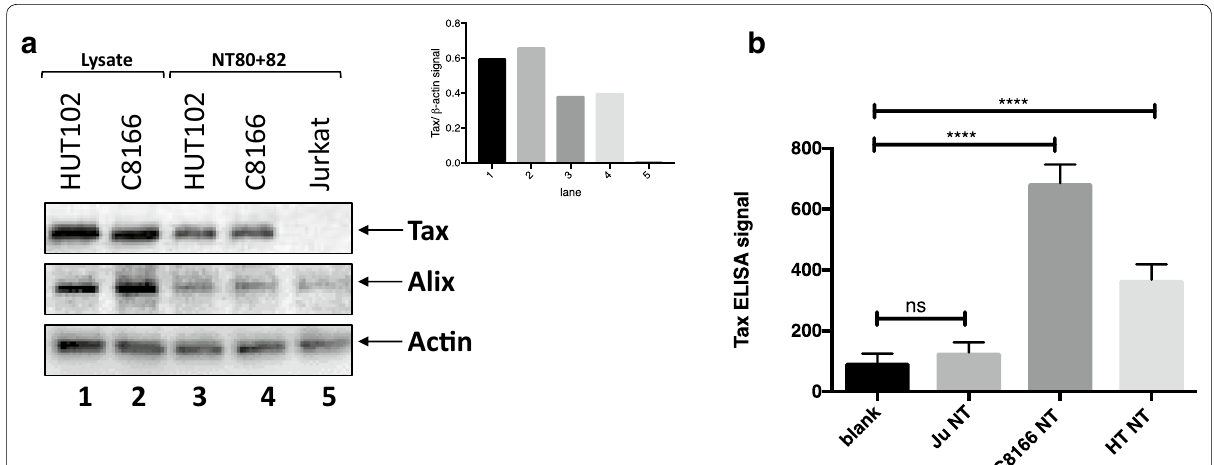
Fig. 2 HTLV‑1 infected cell lines have exosomes containing HTLV‑1 Tax protein. a Western blots for levels of HTLV‑1 Tax, Alix and β‑actin (Actin) proteins were performed from cell lysates and NT80 82 nanotrapped exosomes from HUT102 and C8166 (C81) cells. Jurkat cell supernatants were + also nanotrapped with NT80 82 particles and run alongside infected cell NT pulldowns. Tax levels detected were normalized to the β‑actin signal + for each sample and quantified in the upper right inset. b HTLV‑1 Tax was measured by electrochemical ELISA. Nanotrapped (NT80 from Jurkat (Ju), C8166 (C81), and HUT102 (HT) cells were freeze‑thawed and then measured for HTLV‑1 Tax reactivity. Statistical significance was determined by unpaired t ‑test. **** p ‑value < 0.0001 (n =